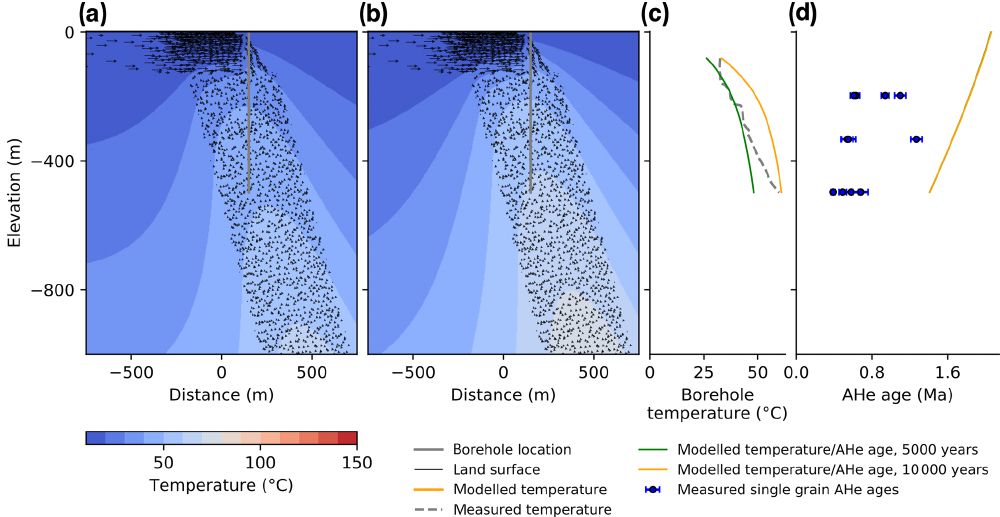
Figure 10. Modelled temperatures and AHe ages for the Brigerbad hydrothermal system after 5000 (a) and 10000 (b) years of hydrothermal activity, assuming a 500m wide flow conduit. The results show that a wide flow conduit fits the borehole temperature data much better (c) , which suggests that a large part of the crystalline bedrock of the Aar massif is permeable enough to channel deep fluids upward. Modelled AHe ages are higher than the observed values (d) , which shows that one episode of flow is not sufficient to reduce AHe